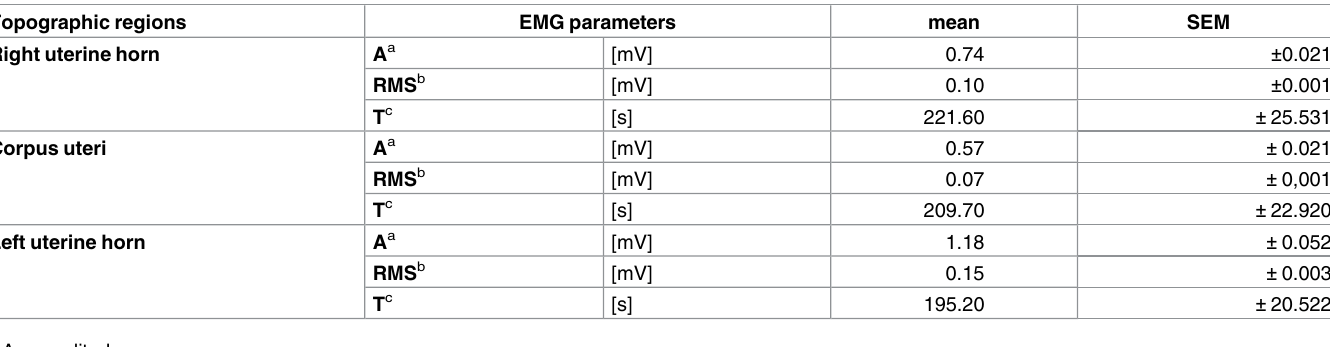
Table 1. EMG signals parameters (mean % ± SEM) of bursts in different topographic regions of uterus. Topographic